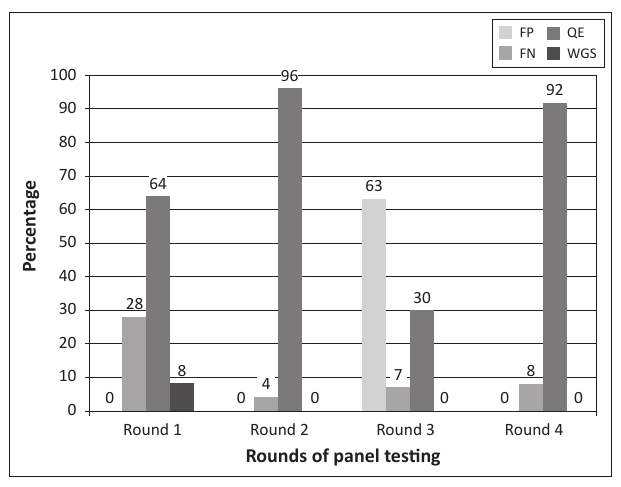
FIGURE 3: Comparison of errors in tuberculosis